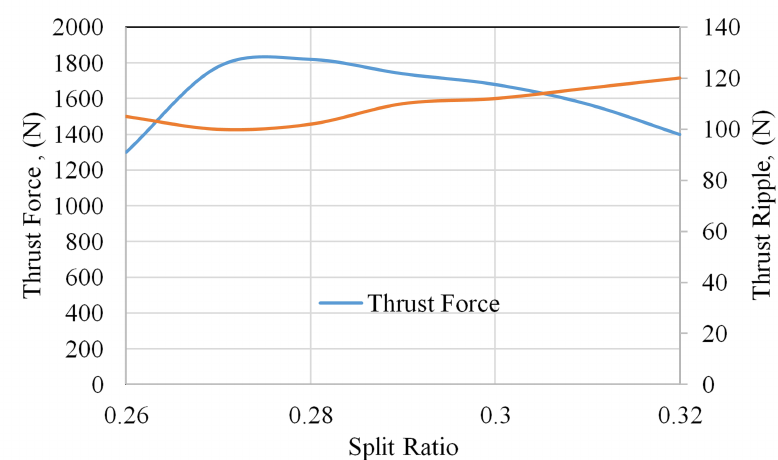
Figure 5. Variation of thrust force and thrust ripple for a novel dual mover yokeless multi- tooth PMFSM.